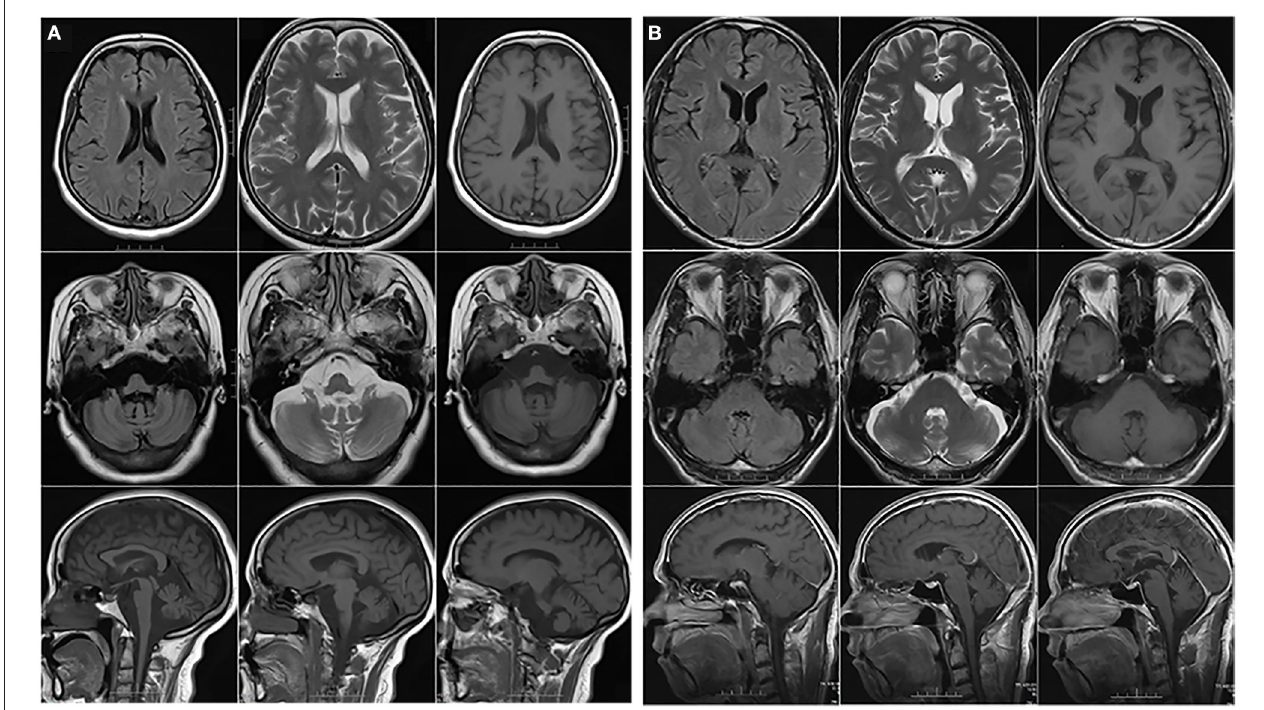
FIGURE 3 | Brain magnetic resonance imaging from patient A0154 (A) and patient A002447 (B) .